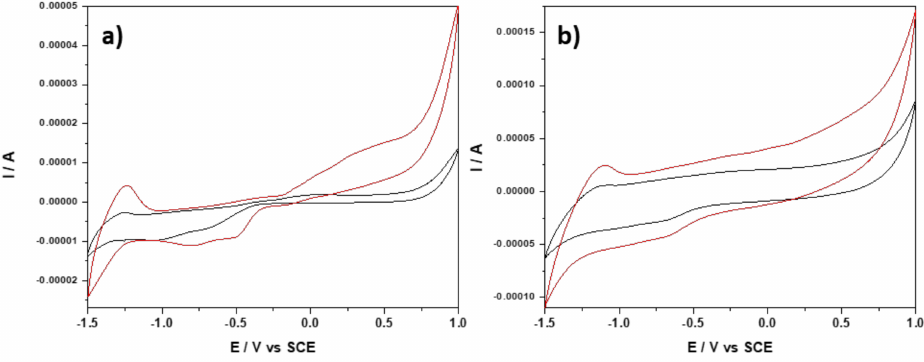
Figure 7. CVs recorded with PE_03 within the potential range of − 1.50 to +1.00 V/SCE in 0.1 M NaOH supporting electrolyte (black curve) and in the presence of 2 mM UA (red curve) at the scan rate: ( a ) 0.01 V · s − 1 and ( b ) 0.3 V · s − 1